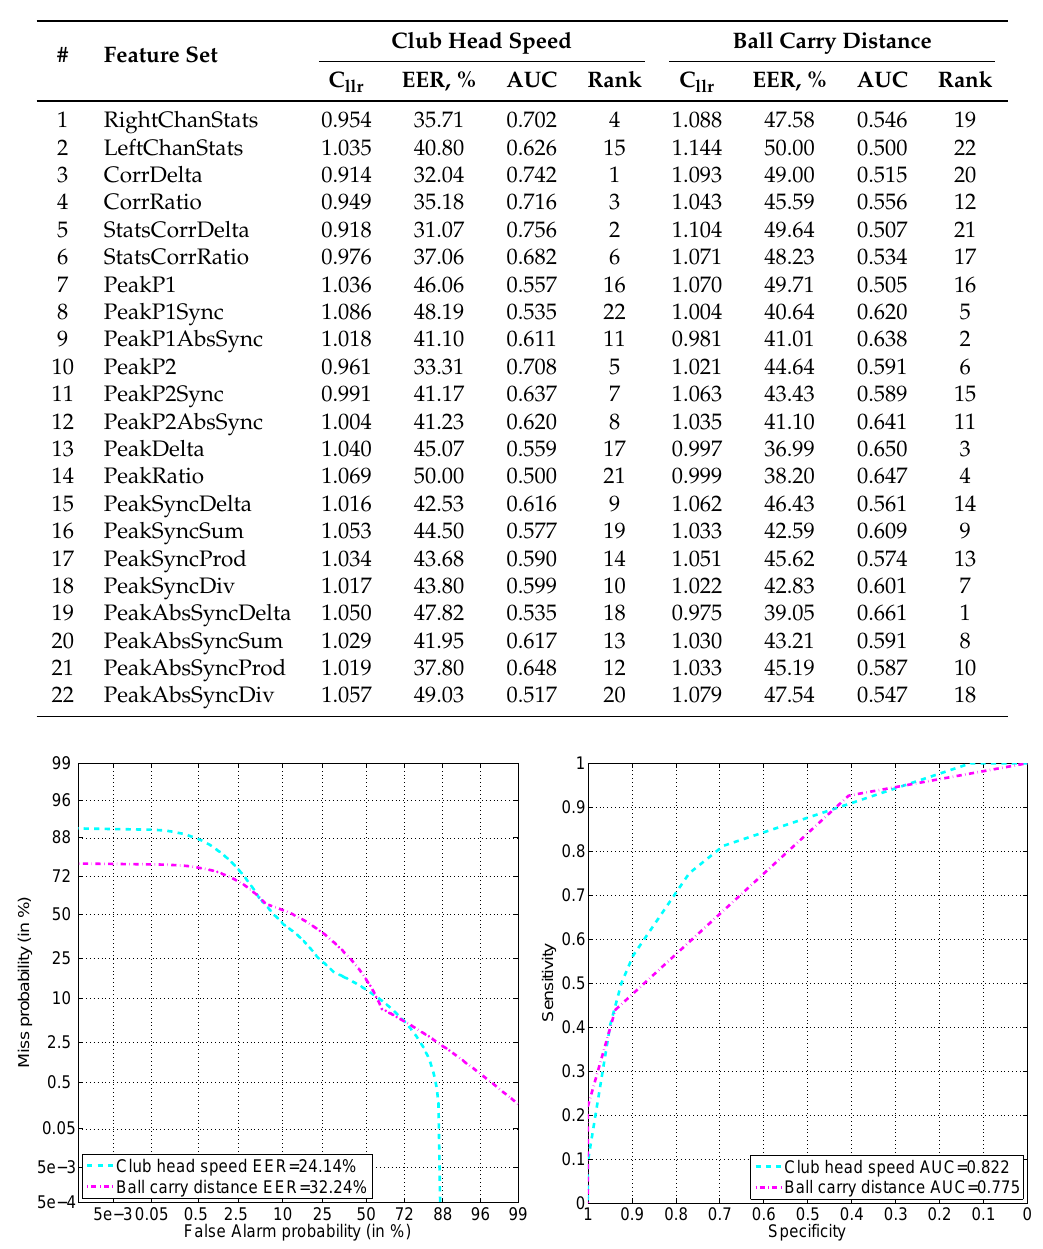
Table 2. RF OOB performance for the detection task.